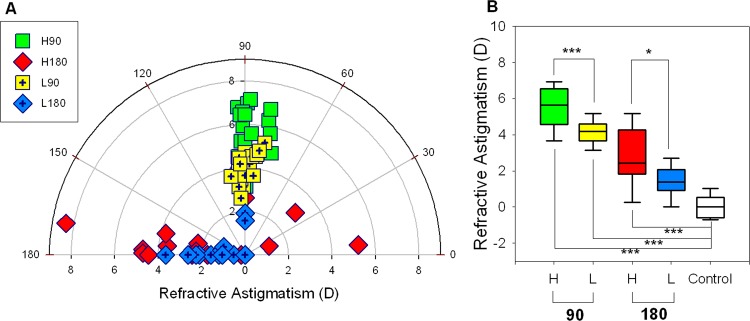
Refractive astigmatism induced by optically imposed astigmatism of two different magnitudes.(A) Distributions of inter-ocular differences in refractive astigmatism for the four treatment groups with cylindrical lenses of two magnitudes ([H]:+4.00DS/-8.00DC and [L]:+2.00DS/-4.00DC) and two axis orientations (H90, H180, and L90; n = 20 in each group; L180, n = 18). See caption for Fig. 2 and text for details. (B) The box plots of refractive astigmatism include the values of median, maximum, minimum, upper and lower quartiles for each group (see Fig. 2 for details). The levels of significant difference in the magnitudes of refractive astigmatism across the treatment groups (lines above the boxes, two-sample t-tests), or between treatment and control group (lines below the boxes, Tukey’s post hoc tests) are indicated by asterisk: * p≤0.05, *** p≤0.001.